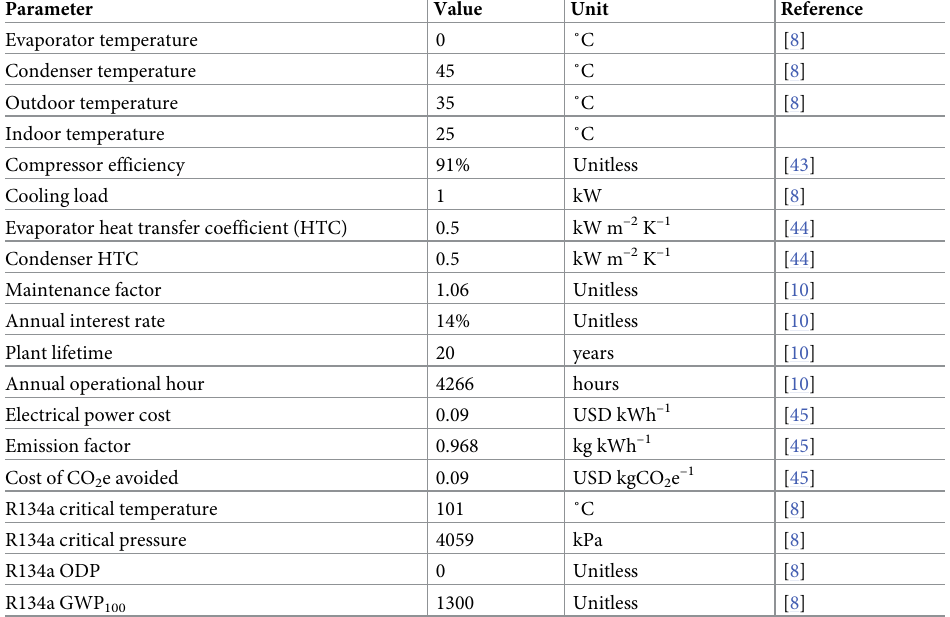
Table 1. Base model design parameters.